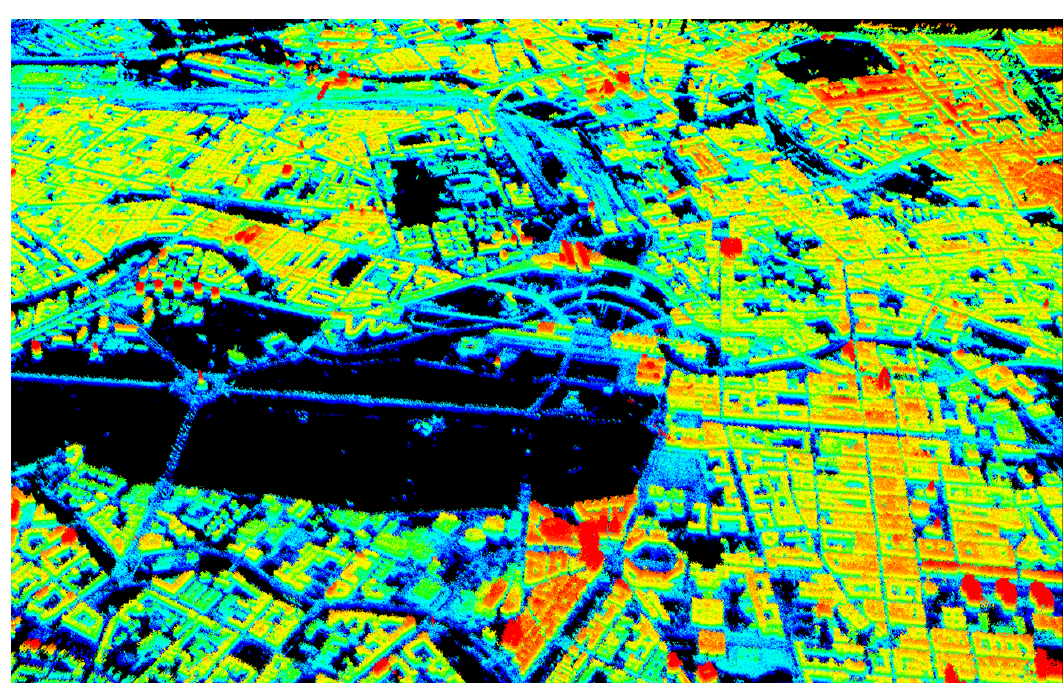
Figure 17. 3D view of central Berlin after geodetic registration of four TomoSAR point clouds obtained from a pair of cross-heading high resolution TerraSAR-X spotlight data. The height is color-coded and ranges between 70 m and 110 m